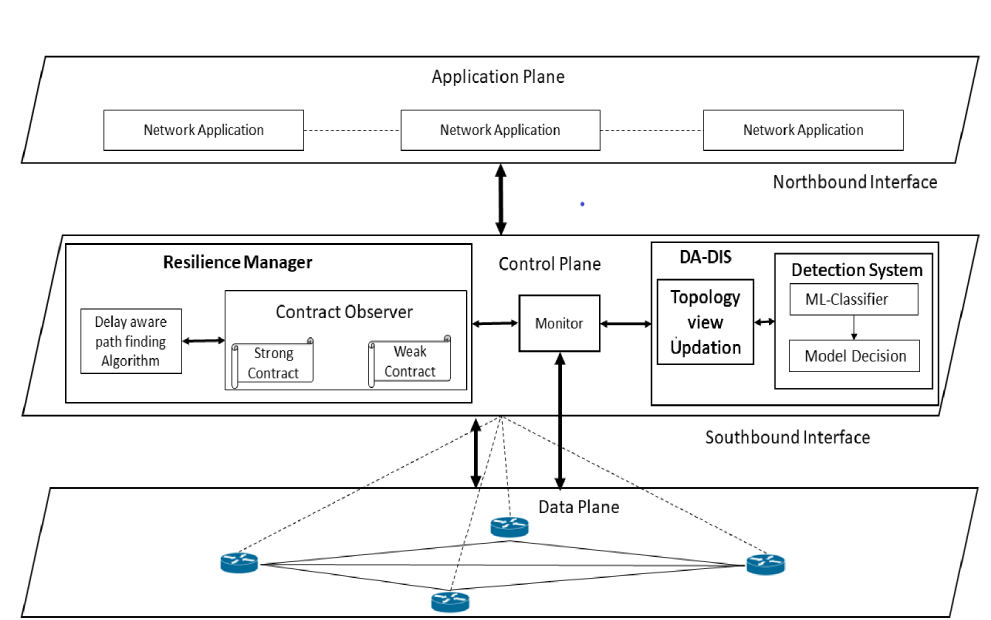
Figure 1. SDN framework for delay attack detection and isolation system (DA-DIS).